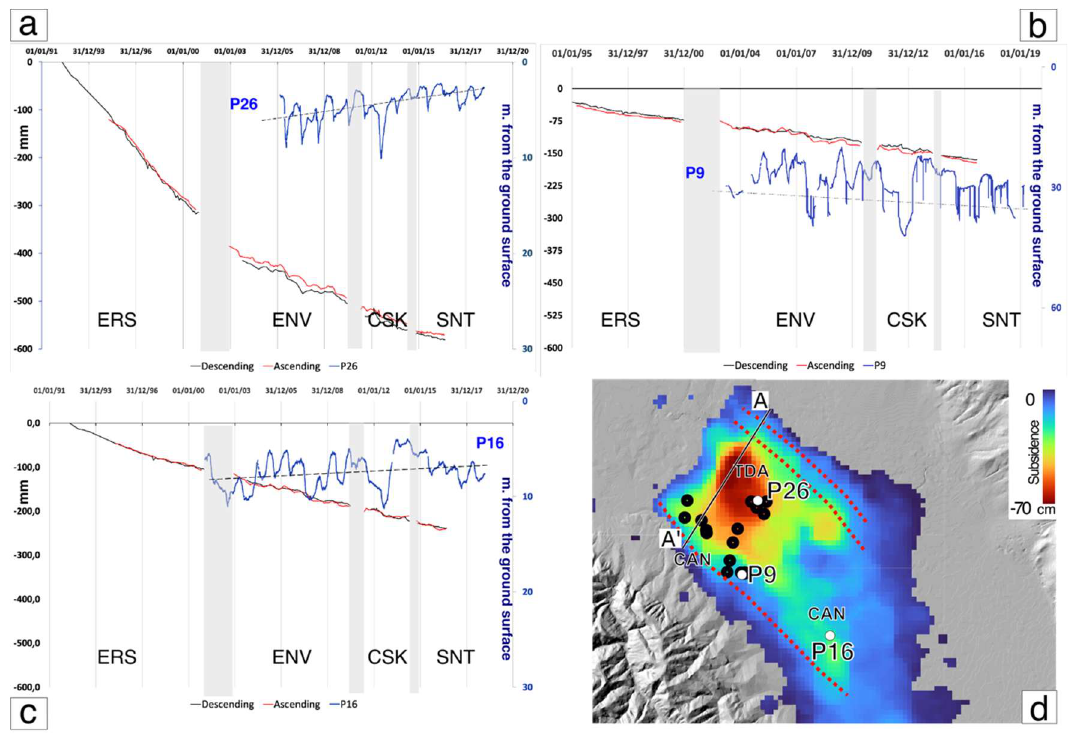
Figure 6. ( a – c ) Ground displacements measured by satellites in the descending (black lines) and ascending (red lines) LOS expressed in mm in three selected zones in correspondence with P9, P16 and P26 wells. The PS time series were compared to the water levels (the blue lines are the water level in the wells from the surface expressed in meters): ( a ) Tordandrea (TDA) and P26 water levels; ( b ) Cerreto (CER) and P9 water levels; ( c ) Cannara (CAN) and P16 water levels. ( d ) Total subsidence map measured by ERS, ENV, CSK and SNT satellites between 1992 and 2016, where black circles between TDA and CER are wells from the Cannara well fields and the white circles are the P9, P16 and P26 wells. The A-A’ line is the profile of Figure 7. The inferred fault system is traced with red dashed lines (see Figures 7 and 8).